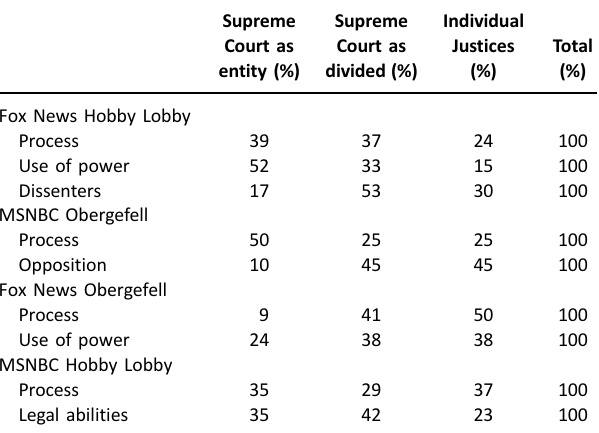
Table 2. Frame-specific terminology